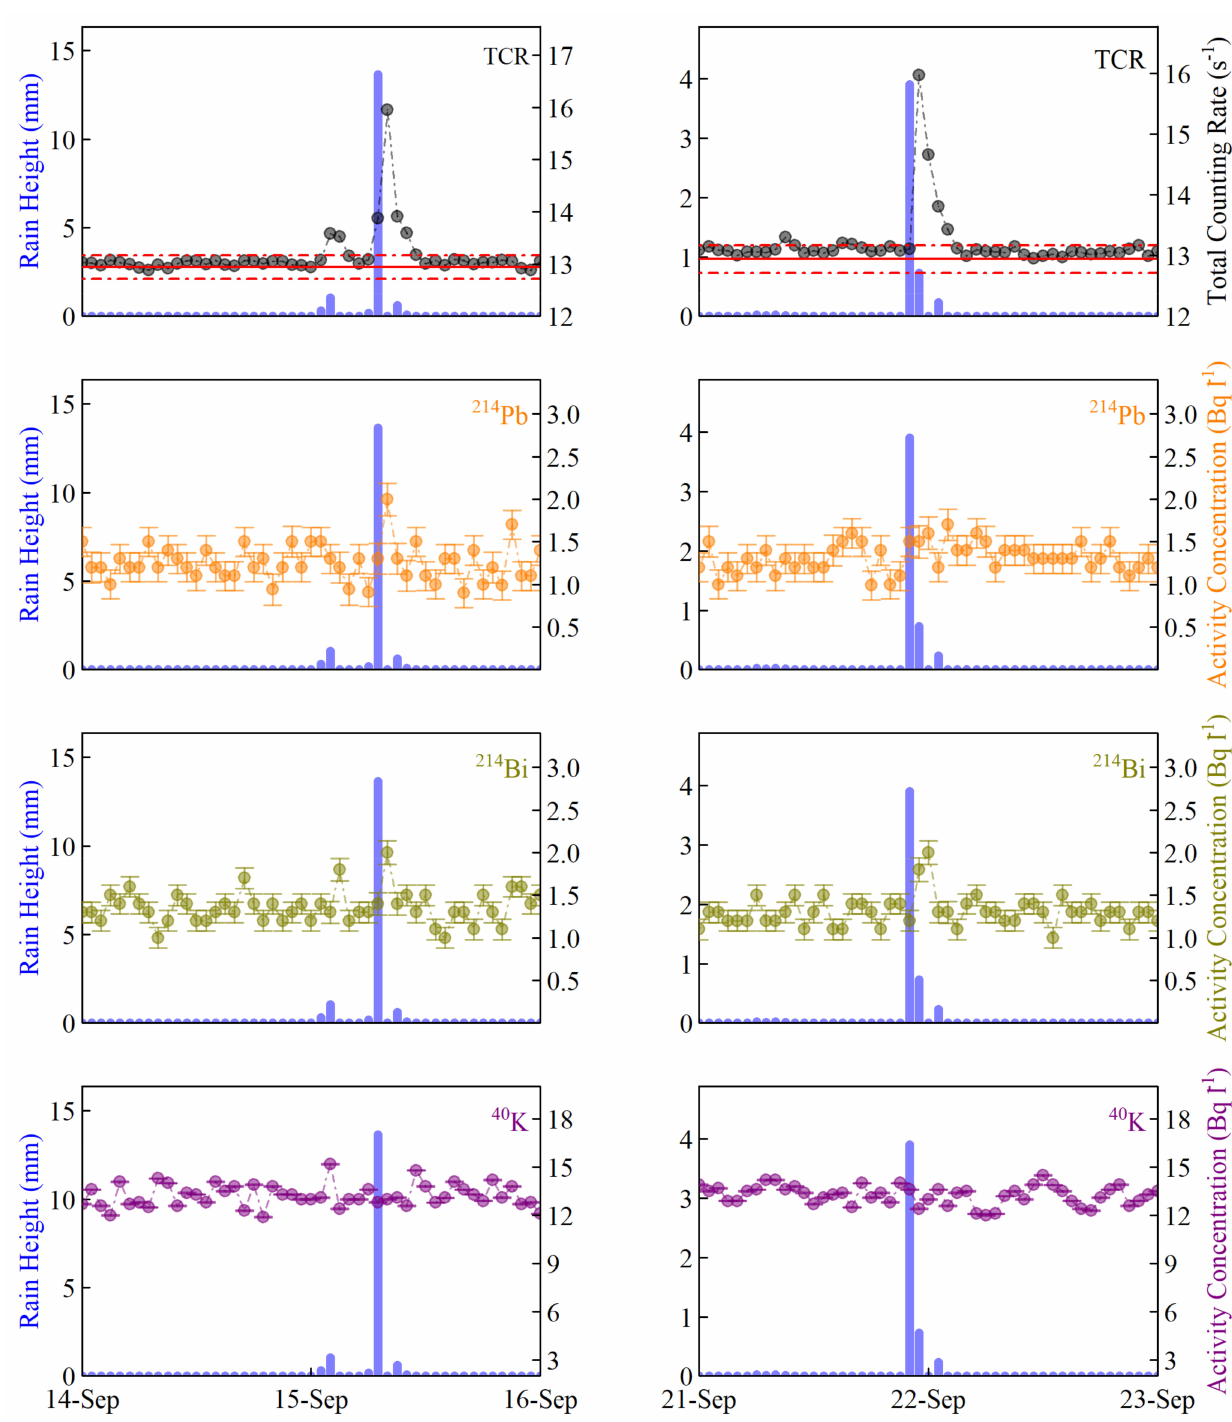
Figure A4. Representative rainfall events of September 2016. The y -axis of the first column regards rain height values (blue bars) while of the second TCR values, 214 Pb, 214 Bi and 40 K activity concentration (circular points). In the subplots of TCR, the mean value during dry meteorological periods is depicted as a red solid line, and the range of the statistically significant criterion is depicted with red dotted